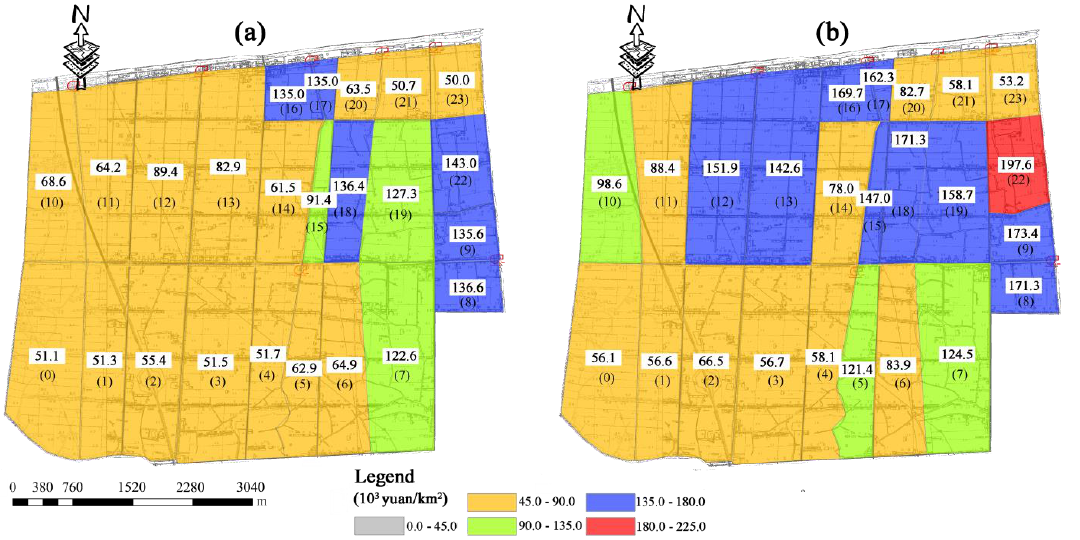
Figure 6. Waterlogging loss under different rainfall return periods of the current scenario (( a ). P2% ( b ). P1%).